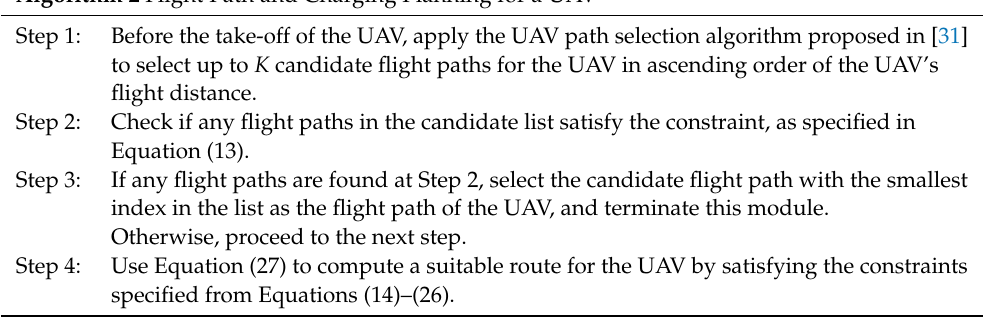
Algorithm 2 Flight Path and Charging Planning for a